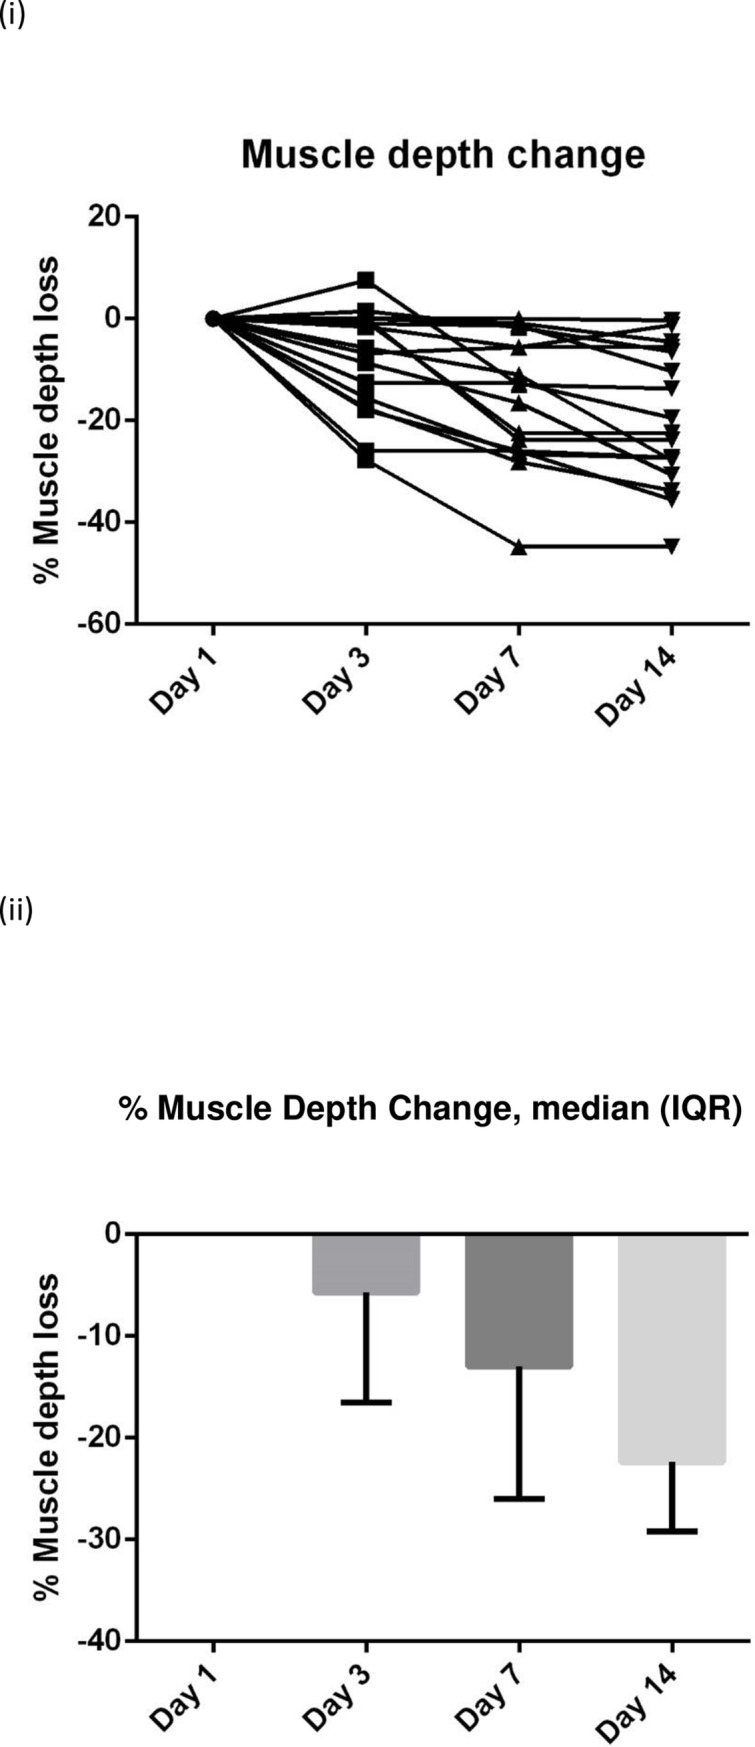
Serial % muscle depth change (N = 17) measurements in long stay patients: (i) Plots to explore individual variability (ii) Box plots reported with median and IQR.